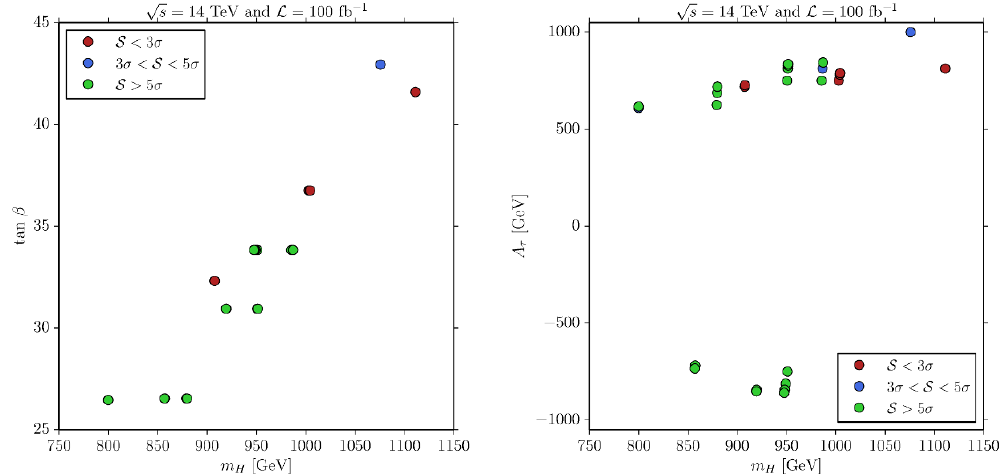
Figure 2 . Signal signi(cid:12)cance in the planes [ m H , tan (cid:12) ] (left panel) and [ m H , A (cid:28) ] (right panel) for various benchmarks within the large stau-mixing MSSM scenario. The displayed values were obtained for a center-of-mass energy of 14 TeV and a total integrated luminosity of 100 fb (cid:0) 1 . Red circles correspond to signi(cid:12)cances below the evidence level ( S < 3 (cid:27) ), blue circles to signi(cid:12)cances between the evidence level and the discovery one (3 (cid:27) < S < 5 (cid:27) ), and green circles to signi(cid:12)cances larger than the discovery level ( S > 5 (cid:27)